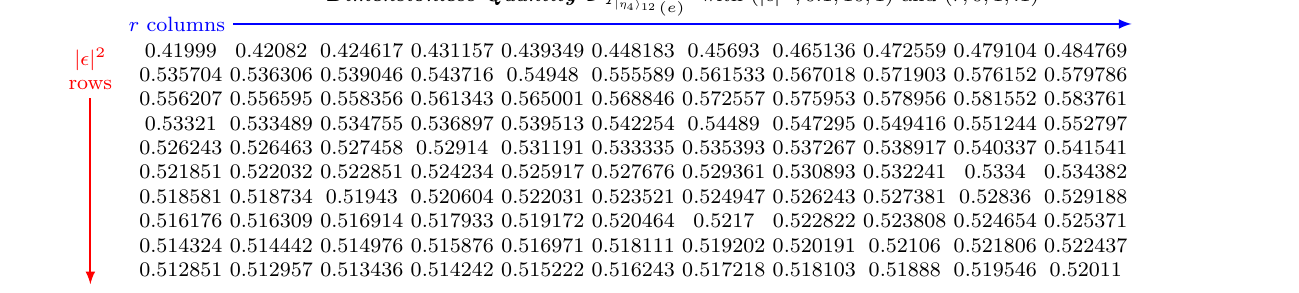
Table 12 Numerical values of D T for some range and choices of coherent and squeezing parameters. Here, | (cid:11) | 2 takes on value from 0 to 10 and r varies from 0 to 1